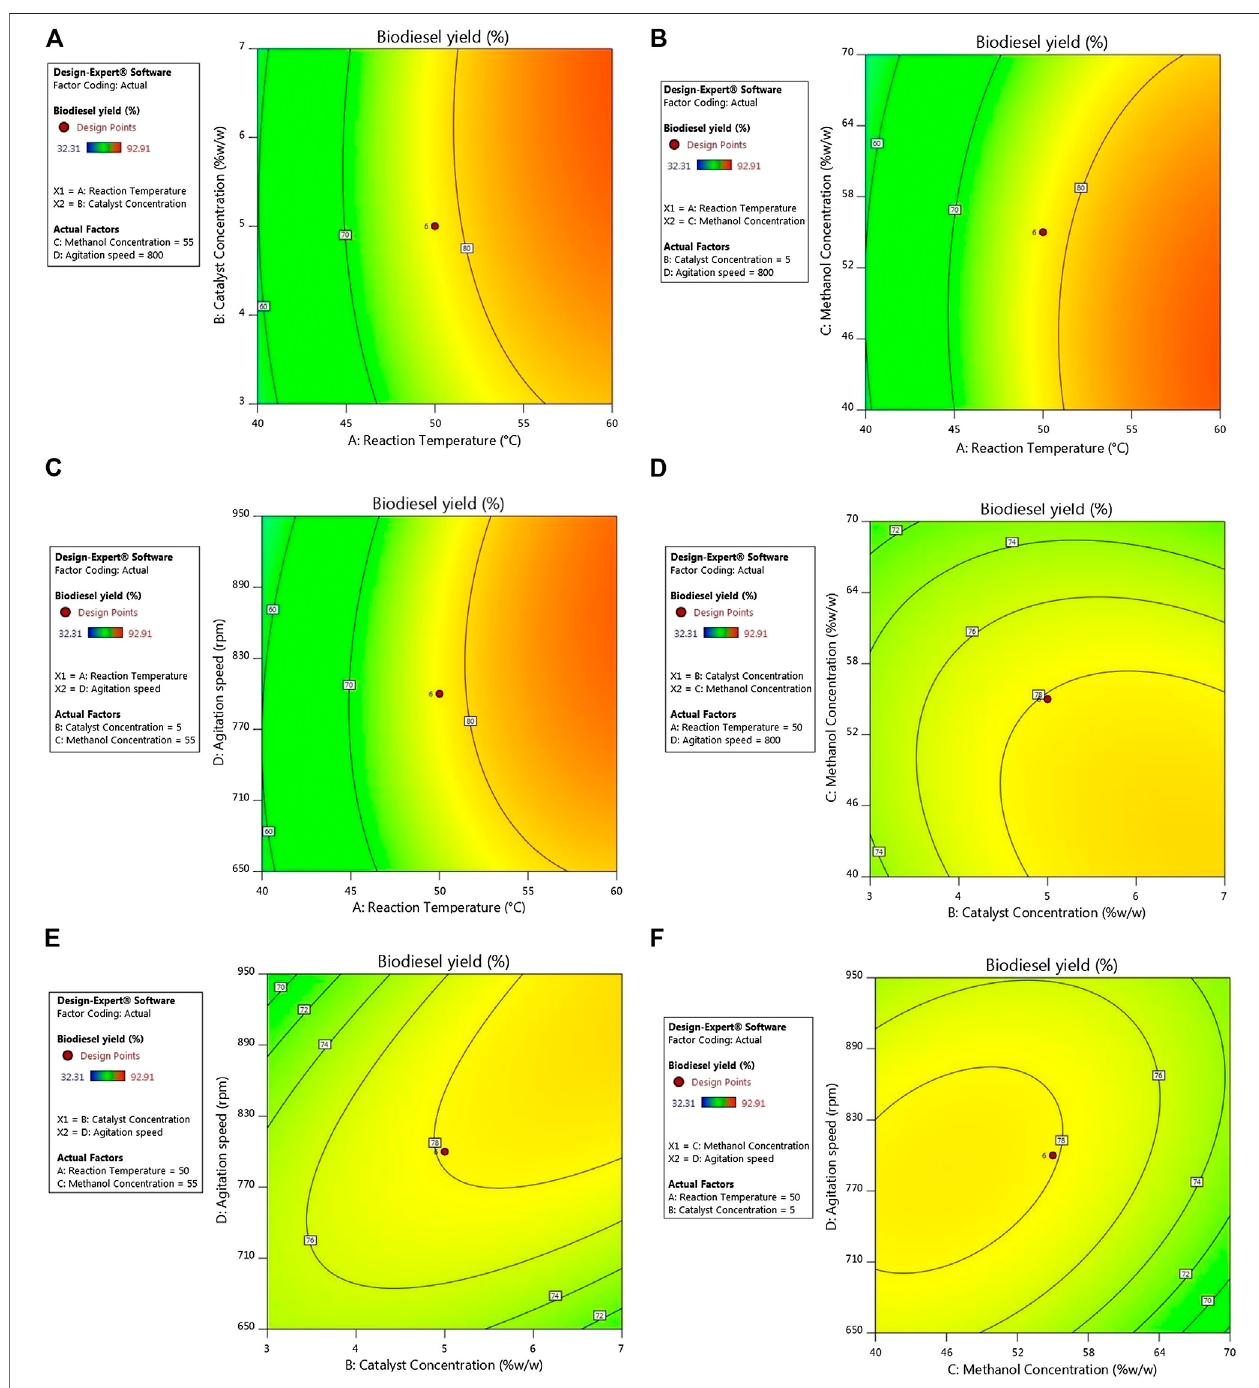
FIGURE 4 | Predicted vs. Actual biodiesel yield